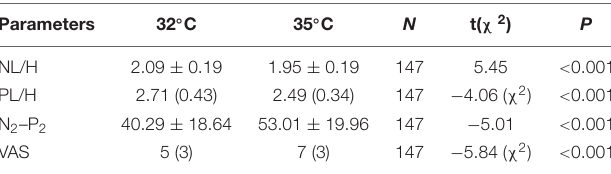
TABLE 5 | Contact heat evoked potential parameters for the right forearm and VAS scores at different baseline temperatures. Parameters